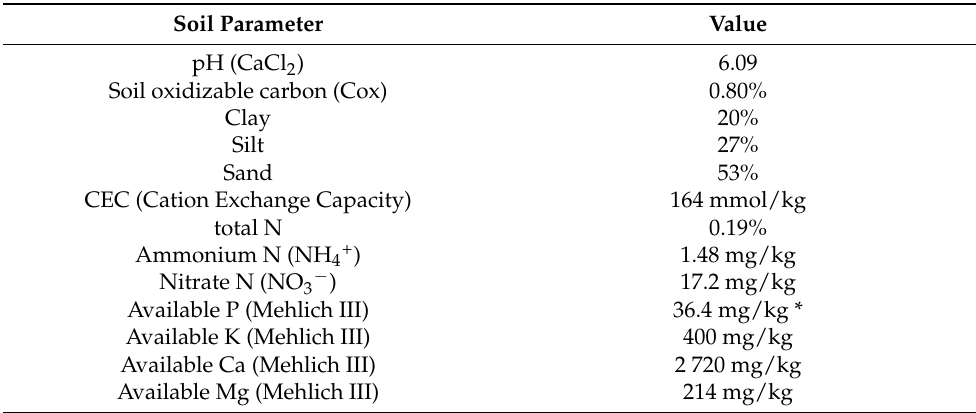
Table 5. Chemical composition of soil used in this